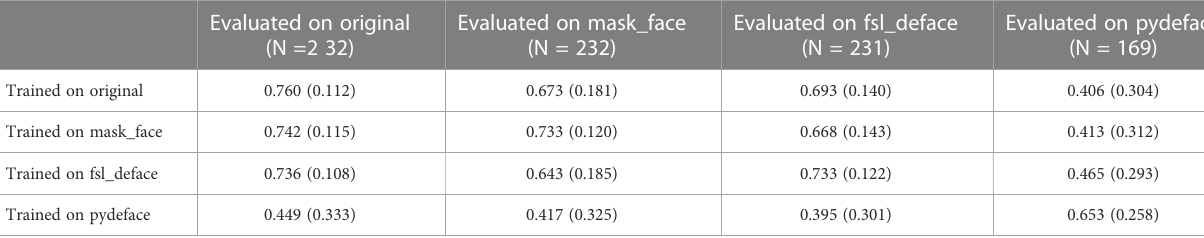
TABLE 2 Composite DSC performance - mean (standard deviation) - of all structures for all combinations of training data (rows) and evaluation data (columns).